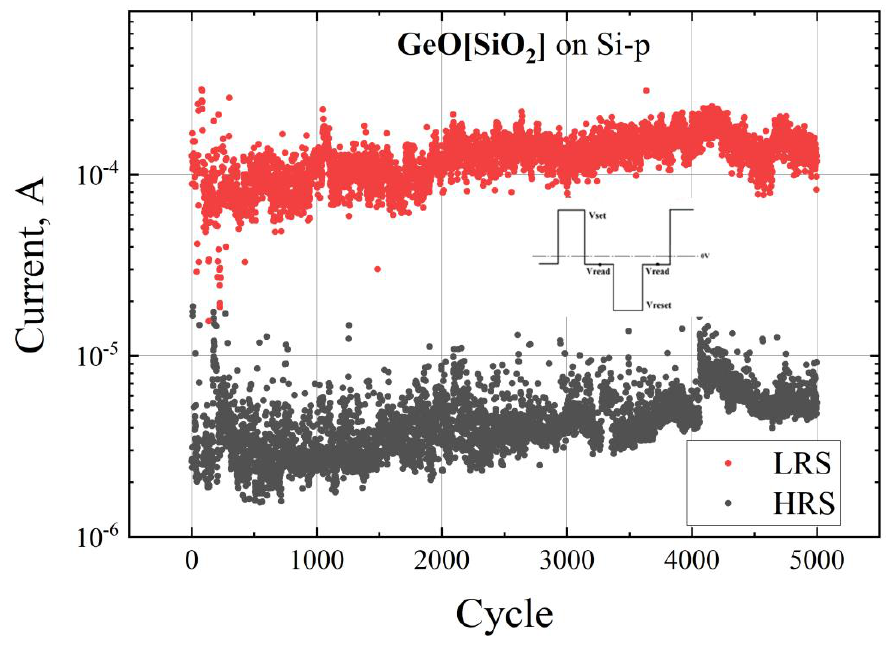
Figure 7. Endurance for sample A.